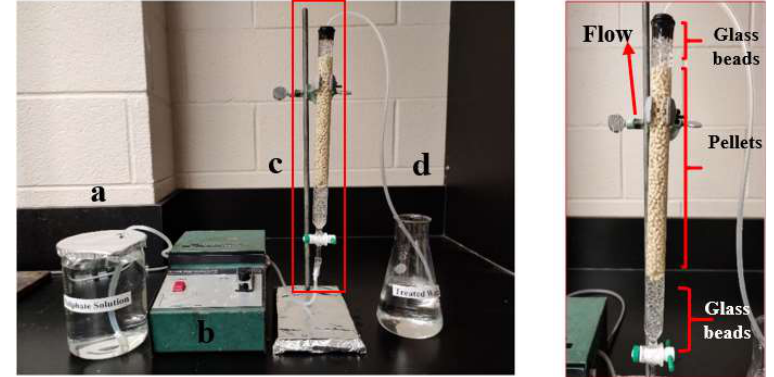
Figure 1. Fixed-bed column reactor packed with chitosan pellets (Ca-CP): ( a ) influent solution, ( b ) peristaltic pump, ( c ) column, and ( d ) influent. The reader is referred to the online version of this article for color images of all graphic files in this document.